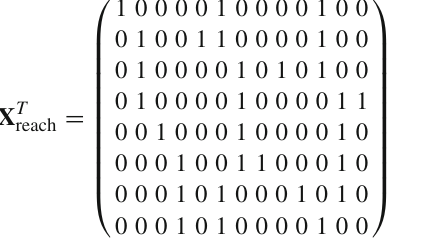
the states: p 5 , p 6 , p 7 , p 8 , p 9 , p 10 ; (iv) the place p 13